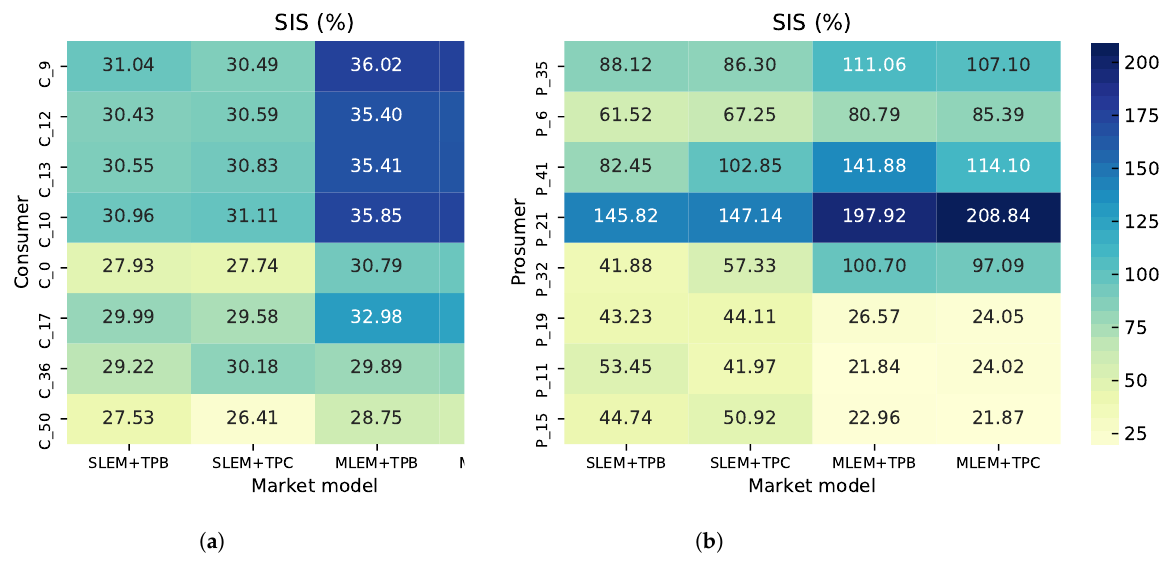
Figure 7. Share of individual savings for selected ( a ) consumers and ( b )